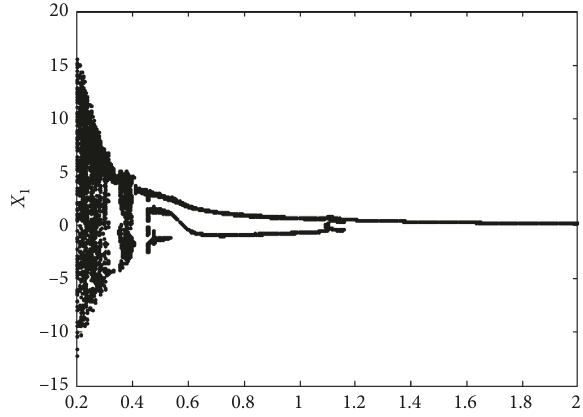
Figure 8: The displacement bifurcation diagram of the aspect ratio ( Ω � 2, ω � 1, c � 0.05, c 1 � 0.05, and c �